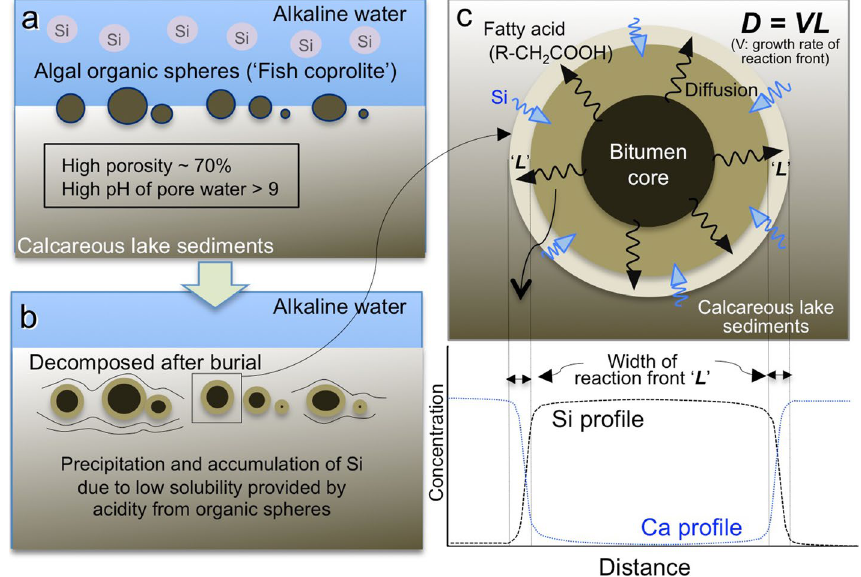
Figure 3. Formation process of silica concretion. Schematic illustration of the process of silica concretion formation after burial of algal organic spheres to form bitumen cores in calcareous lake sediments. ( a ) Concentric algal organic spheres initially grew in calcareous sediments in a shallow and highly alkaline lake rich in dissolved Si. ( b ) Subsequently, the algal organic spheres, probably ‘Fish coprolite’, decomposed and the pH of pore water in the sediment around the organic spheres decreased. The decreased pH of the pore waters then caused the abundant dissolved silica to precipitate around the decomposed organic spheres. ( c ) Conceptual view of the features of ellipsoidal silica concretions and relevant elemental (Si, Ca) profiles. The Si profile across the concretion formed in rather stable conditions under which solutes diffused continuously, driven by pH buffering and associated silica